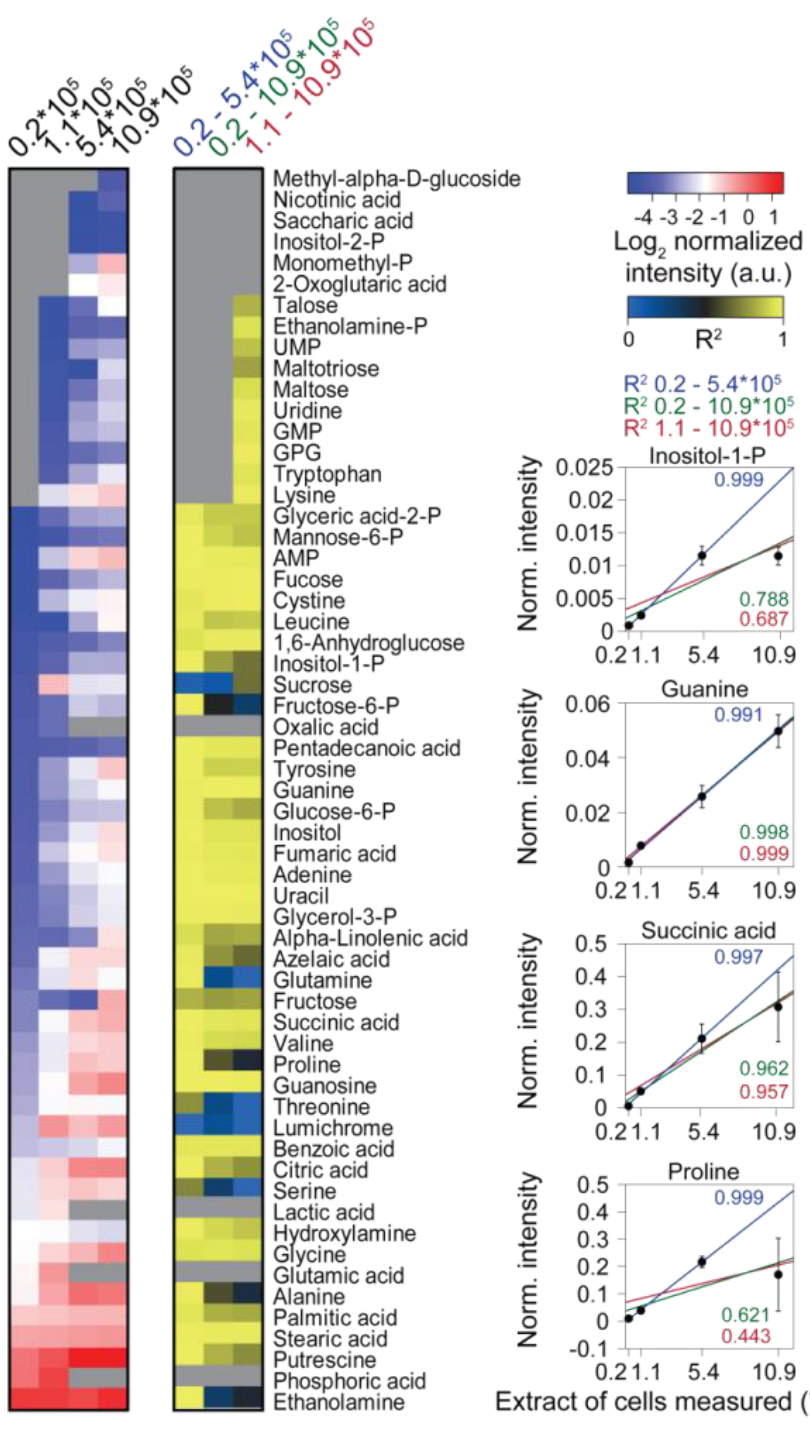
Figure 4. The effect of matrix complexity on the linearity of individual metabolite responses. ( Left ) Heat map of metabolites measured from differently concentrated extracts, the measured extract corresponding to the amount of cells is indicated at the top. ( Middle ) Heat map of the coefficients of determination (R 2 ) values obtained by linear regression of the metabolite data from (left), including different samples as indicated at the top. Missing data are shown as grey boxes in the heat maps. ( Right ) The panel shows exemplarily the normalized abundance of four metabolites and the respective regression